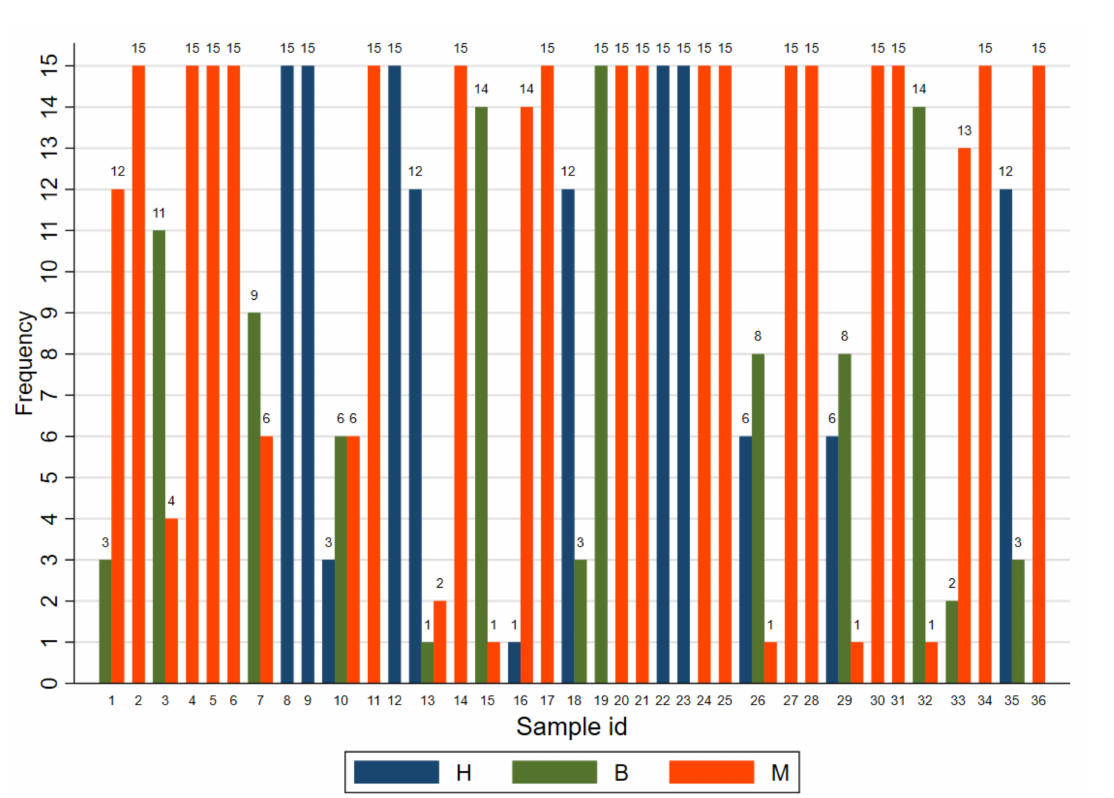
Figure 1. Frequency of results in terms of hyperplasia-dysplasia (H), benign (B), or malignant (M) communicated by individual readers, by sample identification